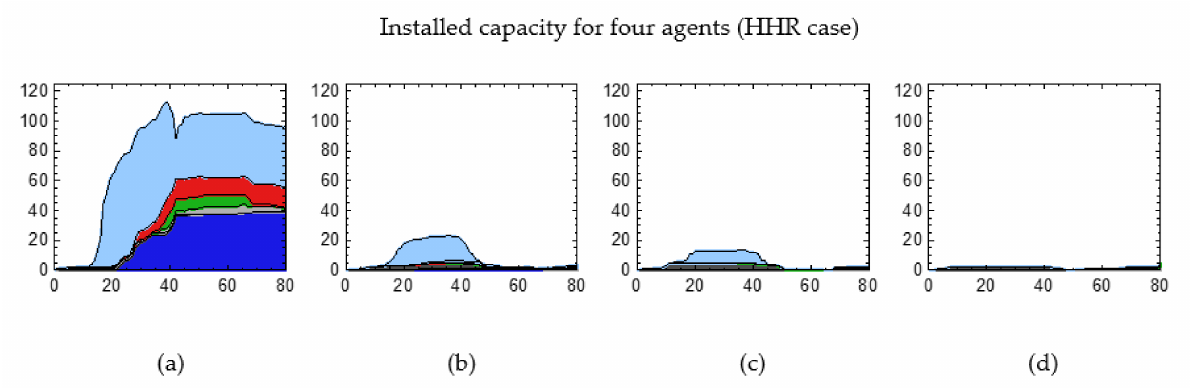
Figure 3. Illustration of the installed capacity for some agents in HHR case, ( a ) r = 5.0%, ( b ) r = 5.25%, ( c ) r = 5.5%, ( d ) r = 5.75%. The agent with r = 5% dominates the investing, while agents with r > 6.75% make no